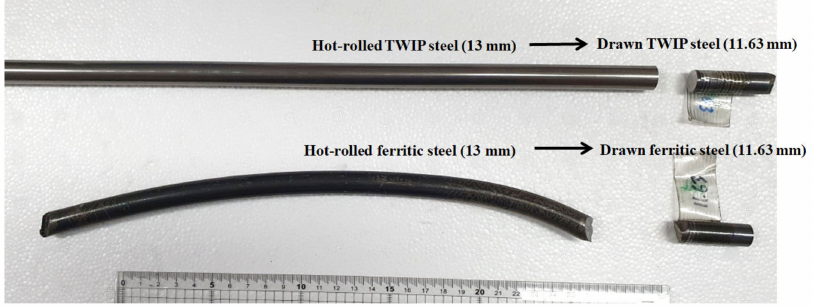
Figure 6. Photograph of the hot-rolled and drawn low-carbon and TWIP steel wires.